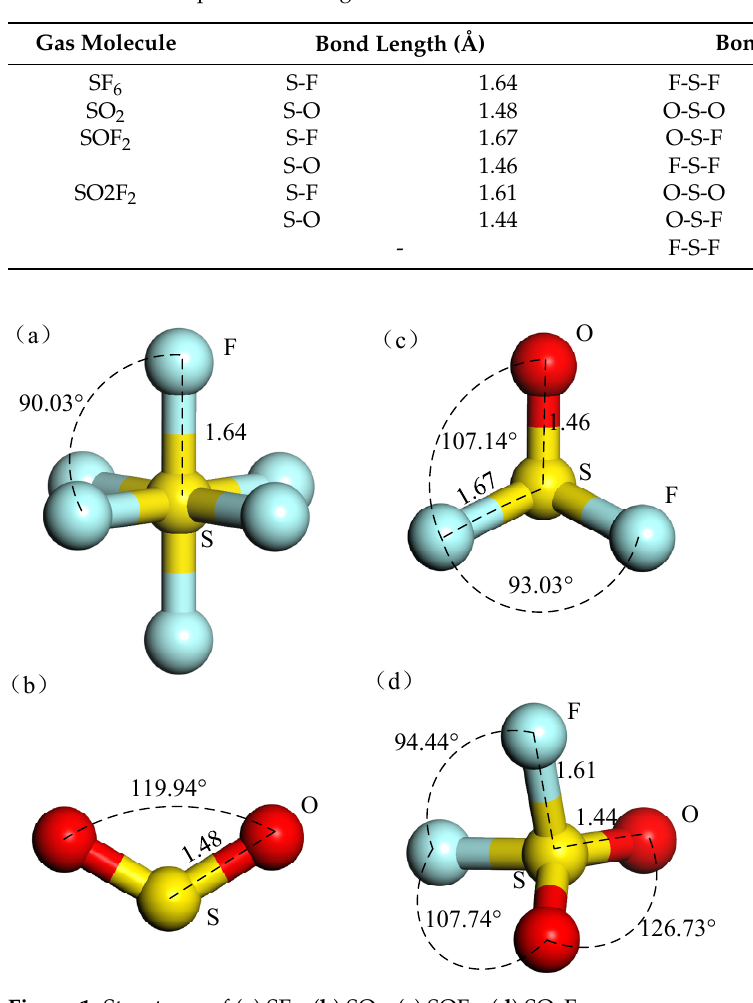
Figure 1. Structures of ( a ) SF 6 , ( b ) SO 2 , ( c ) SOF 2 , ( d ) SO 2 F 2